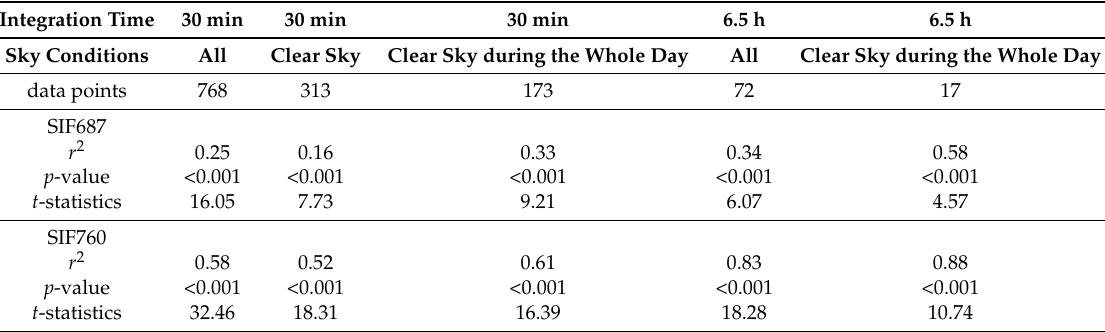
Table 4. Statistics of the linear regression between SIF and GPP as a function of experimental